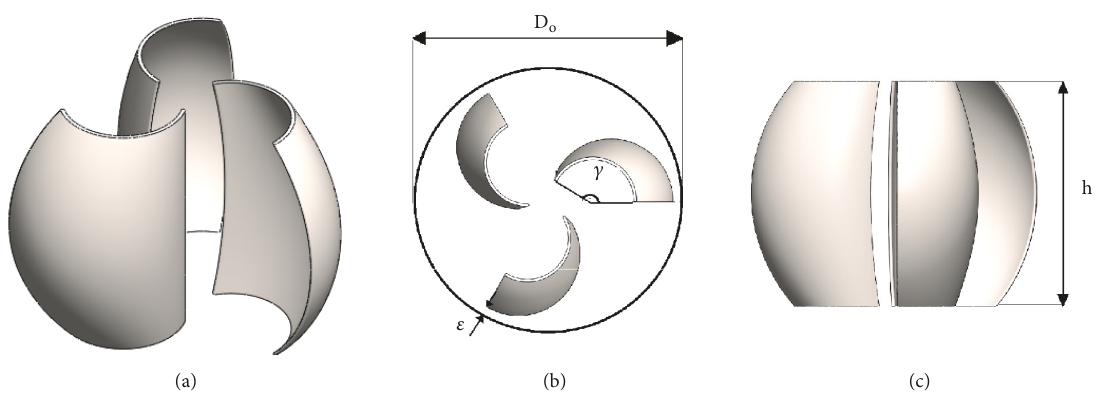
Figure 1: 3-bladed in-pipe Savonius turbine: (a) Isometric view; (b) top view; (c) front